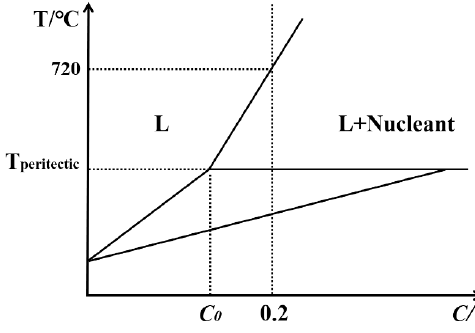
Figure 6. Schematic illustration showing the Al-Zr peritectic reaction.